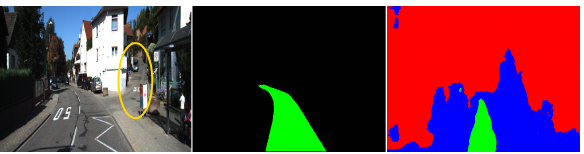
Figure 9: Test image from the KITTI dataset (left). Groundtruth label for the same test image (middle) and the output of our upper bound network (right).